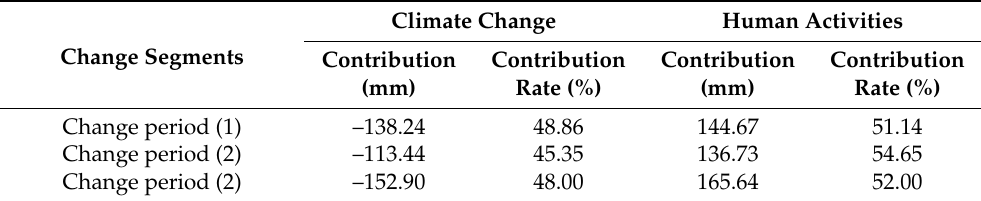
Figure 8. Attribution based on Budyko theory. Table 8. Rates of contribution to runoff change by the Budyko method.